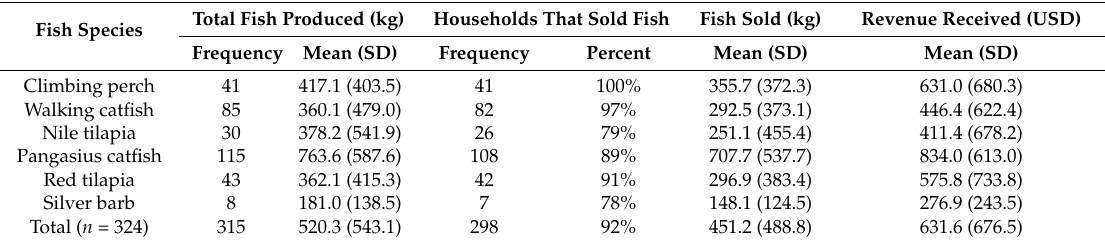
Table 6. Fish production and sales, by